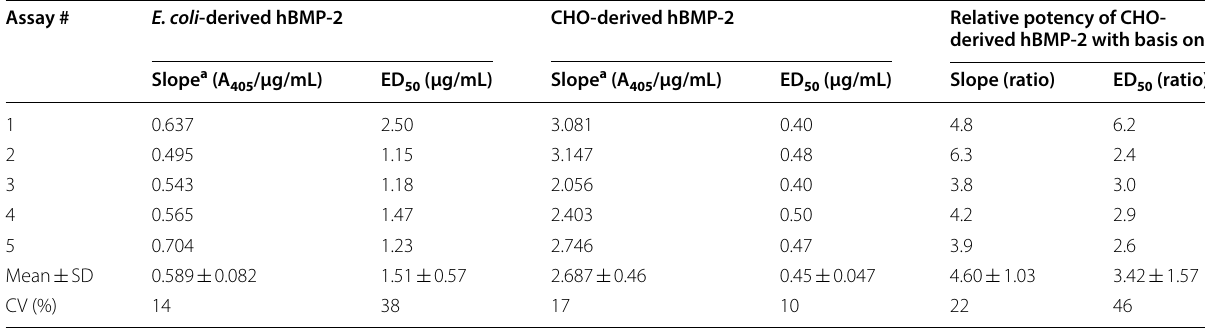
Table 1 Comparison between the “in vitro” biological activity of CHO-derived (Infuse) and of E. coli -derived (GenScript) hBMP-2 preparations